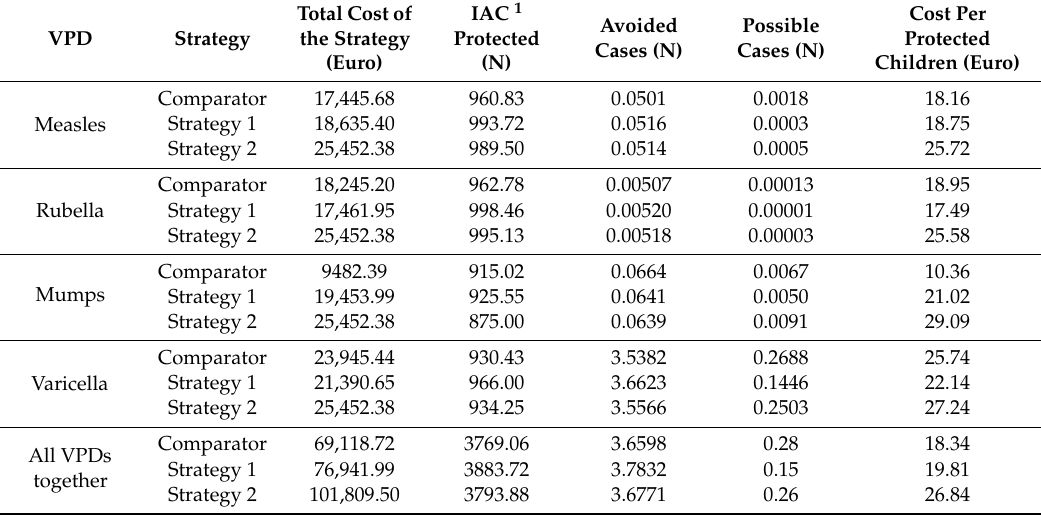
Table 7. Clinical and economic outcomes per 1000 Internationally Adopted Children (IAC), by disease (ELISA method).